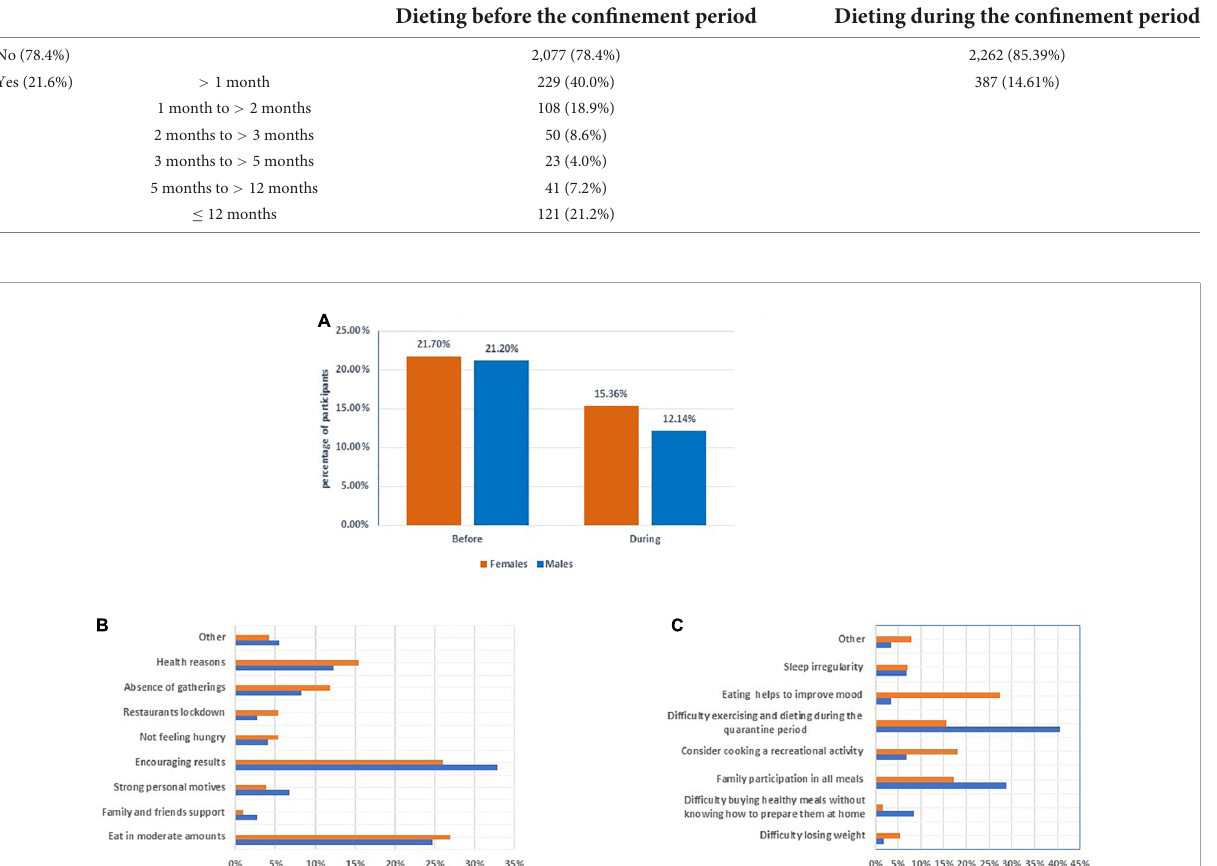
TABLE 2 Dieting before and during the confinement period.